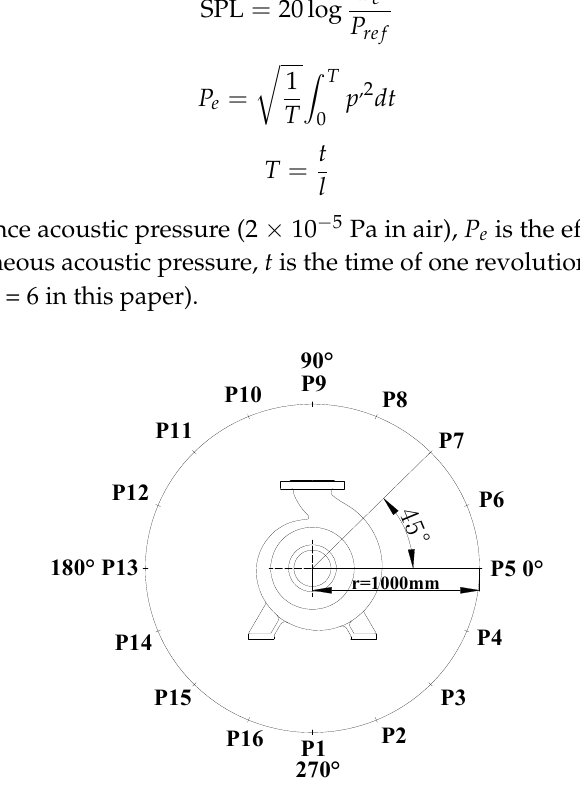
Figure 4. Arrangement of monitoring points in circumferential direction.